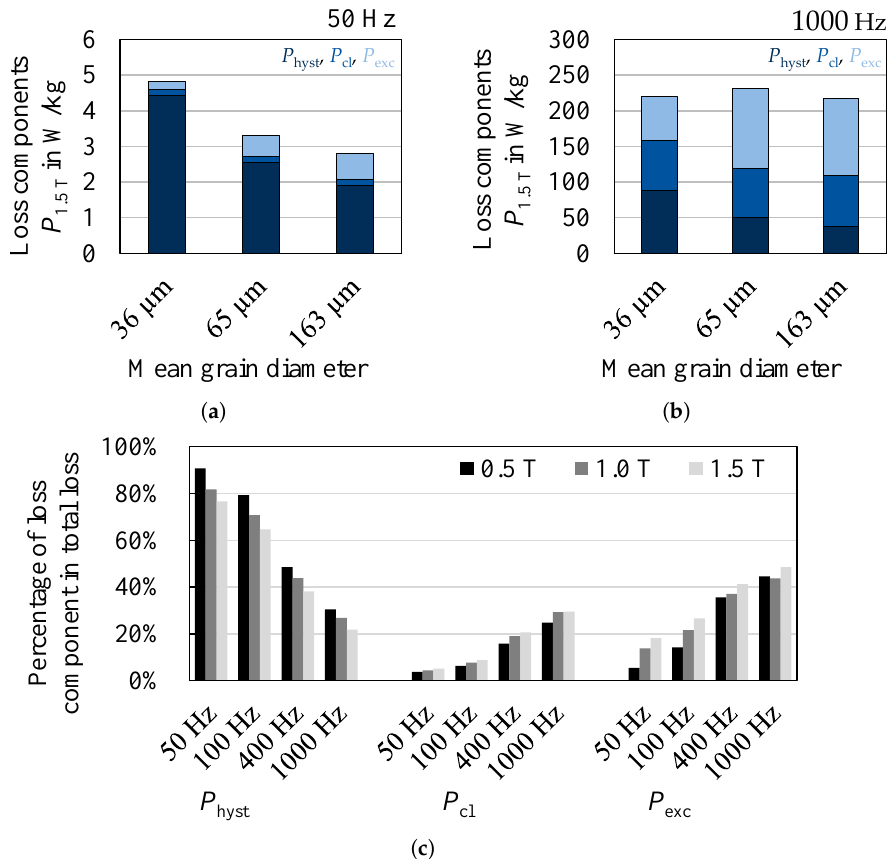
Figure 20. Loss component distribution at 1.5T for three 0.25mm thick non-oriented electrical steel grades at ( a ) 50Hz and ( b ) 1000Hz, and ( c ) loss component distribution for the sample with a mean grain size of 65µm and thickness of